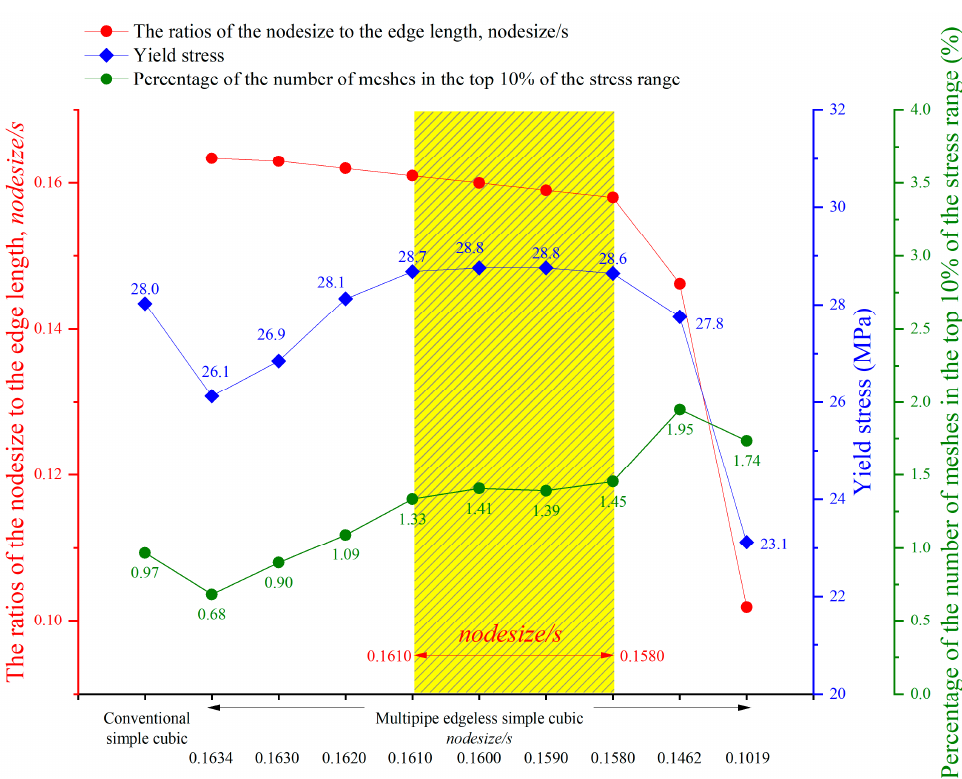
Figure 17. FEA results for the multipipe edgeless simple cubic unit cells.